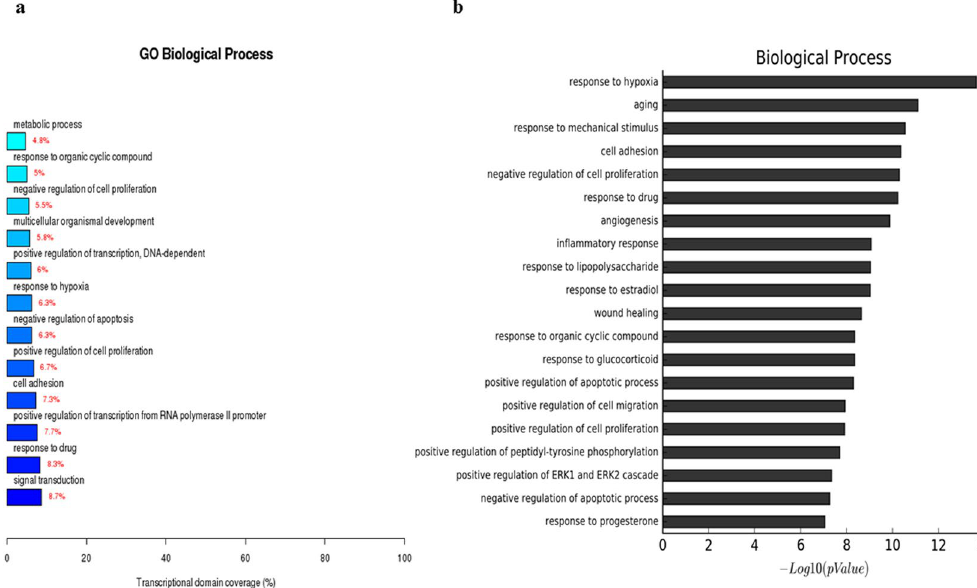
Figure 6. The RCCS-3D vs static-2D group comparison that gene ontology analysis of differentially expressed genes in biological process. ( a ) Top 20 terms based on most significant p value of biological processes. ( b ) Top 12 terms based on the differential genes were most extensive transcriptional domain coverage.